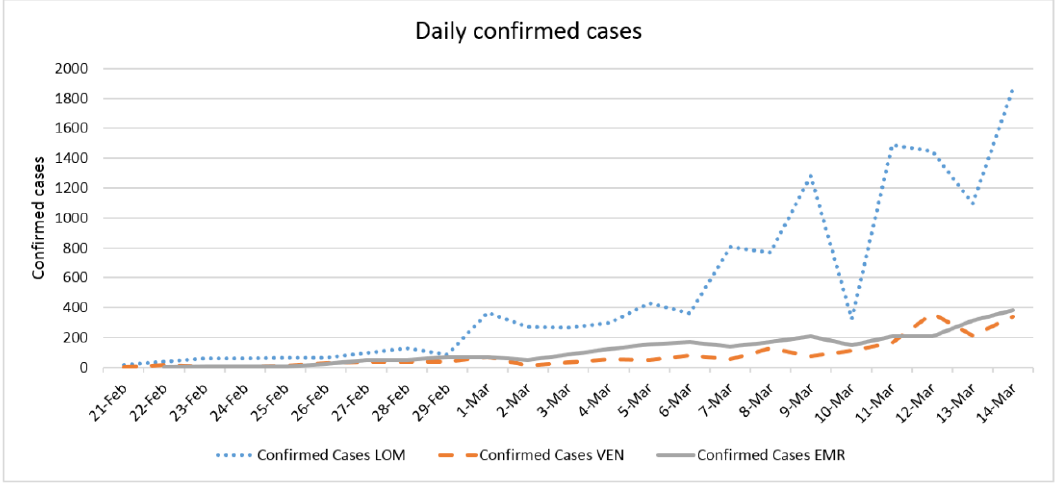
Figure 2. The daily confirmed cases of COVID-19 in three case studies.